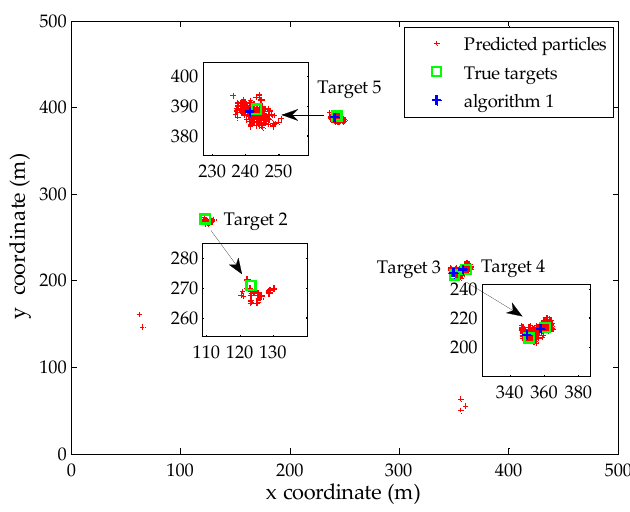
Figure 2. The output of the SMC-PHD filter at time step 35.